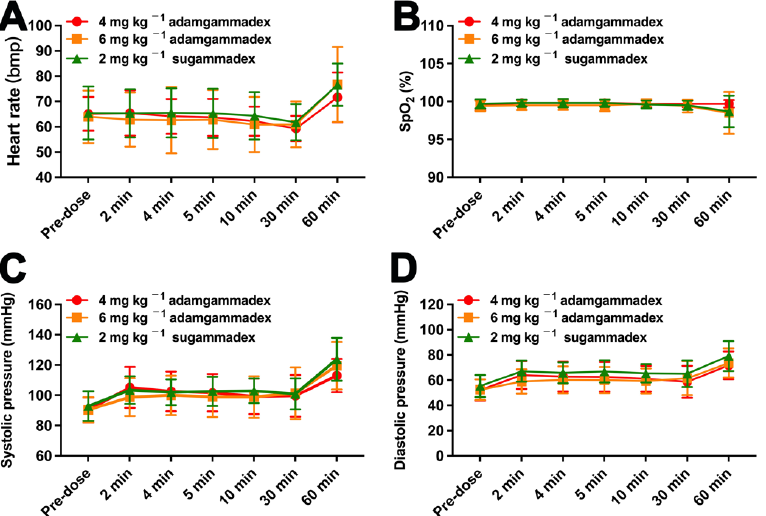
Figure 5. The basic vital signs, including heart rate ( A ), pulse-oximetry (SpO 2 , ( B )), systolic pressure ( C ) and diastolic pressure ( D ), in patients after injected with adamgammadex or sugammadex .